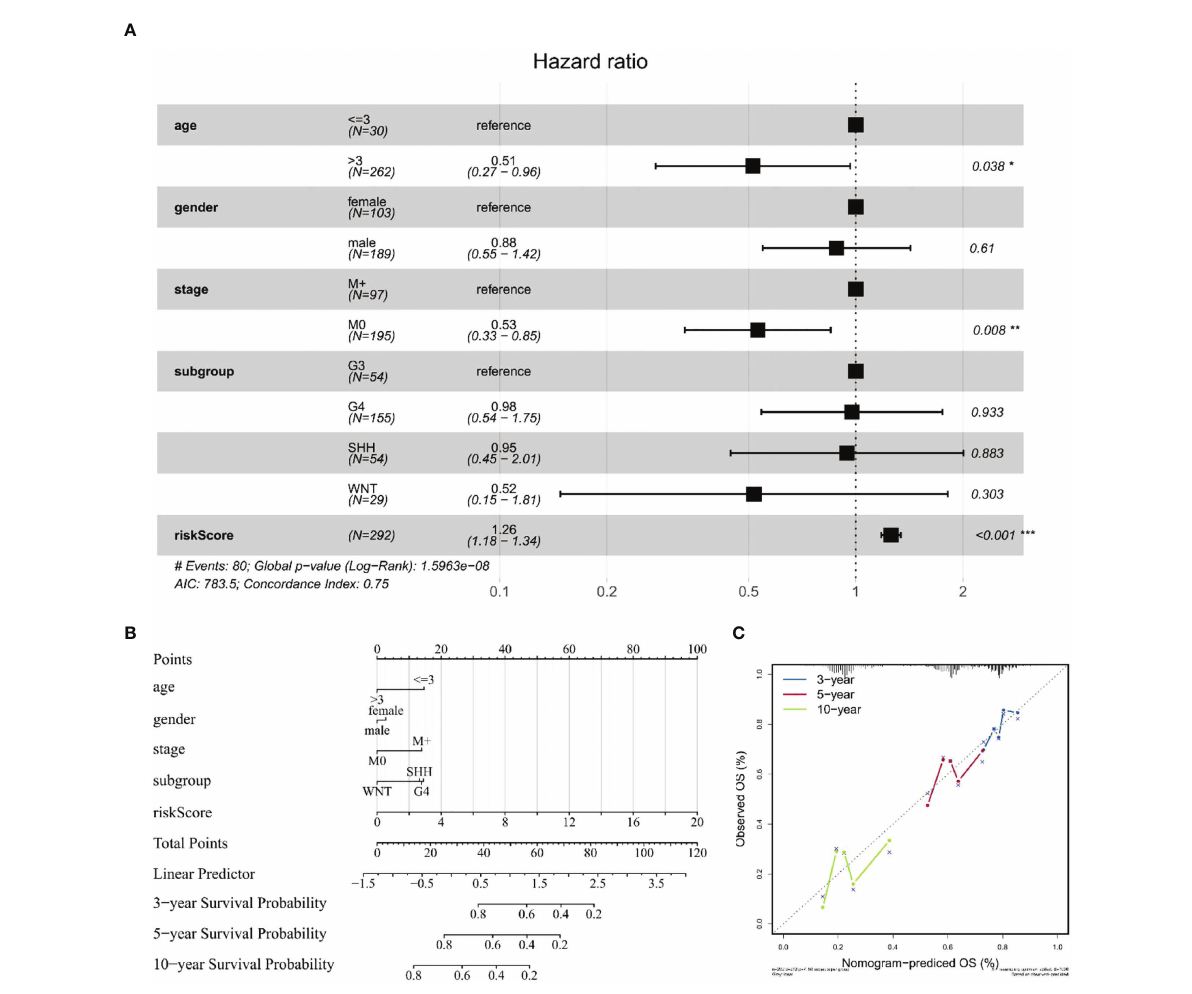
FIGURE 8 Construction and validation of a nomogram for survival prediction. (A) Multivariate Cox regression analysis of the association among clinical factors, risk score, and OS. (B) Nomogram combining the 10 hub gene signature and clinical factors. (C) Validation of the accuracy of the prognostic model with dataset GSE85217. The symbol "*" means FDR adjusted p value for the labeled correlation was less than 0.05, "**" means FDR adjusted p value for the labeled correlation was less than 0.01, and "***" means FDR adjusted p value for the labeled correlation was less than